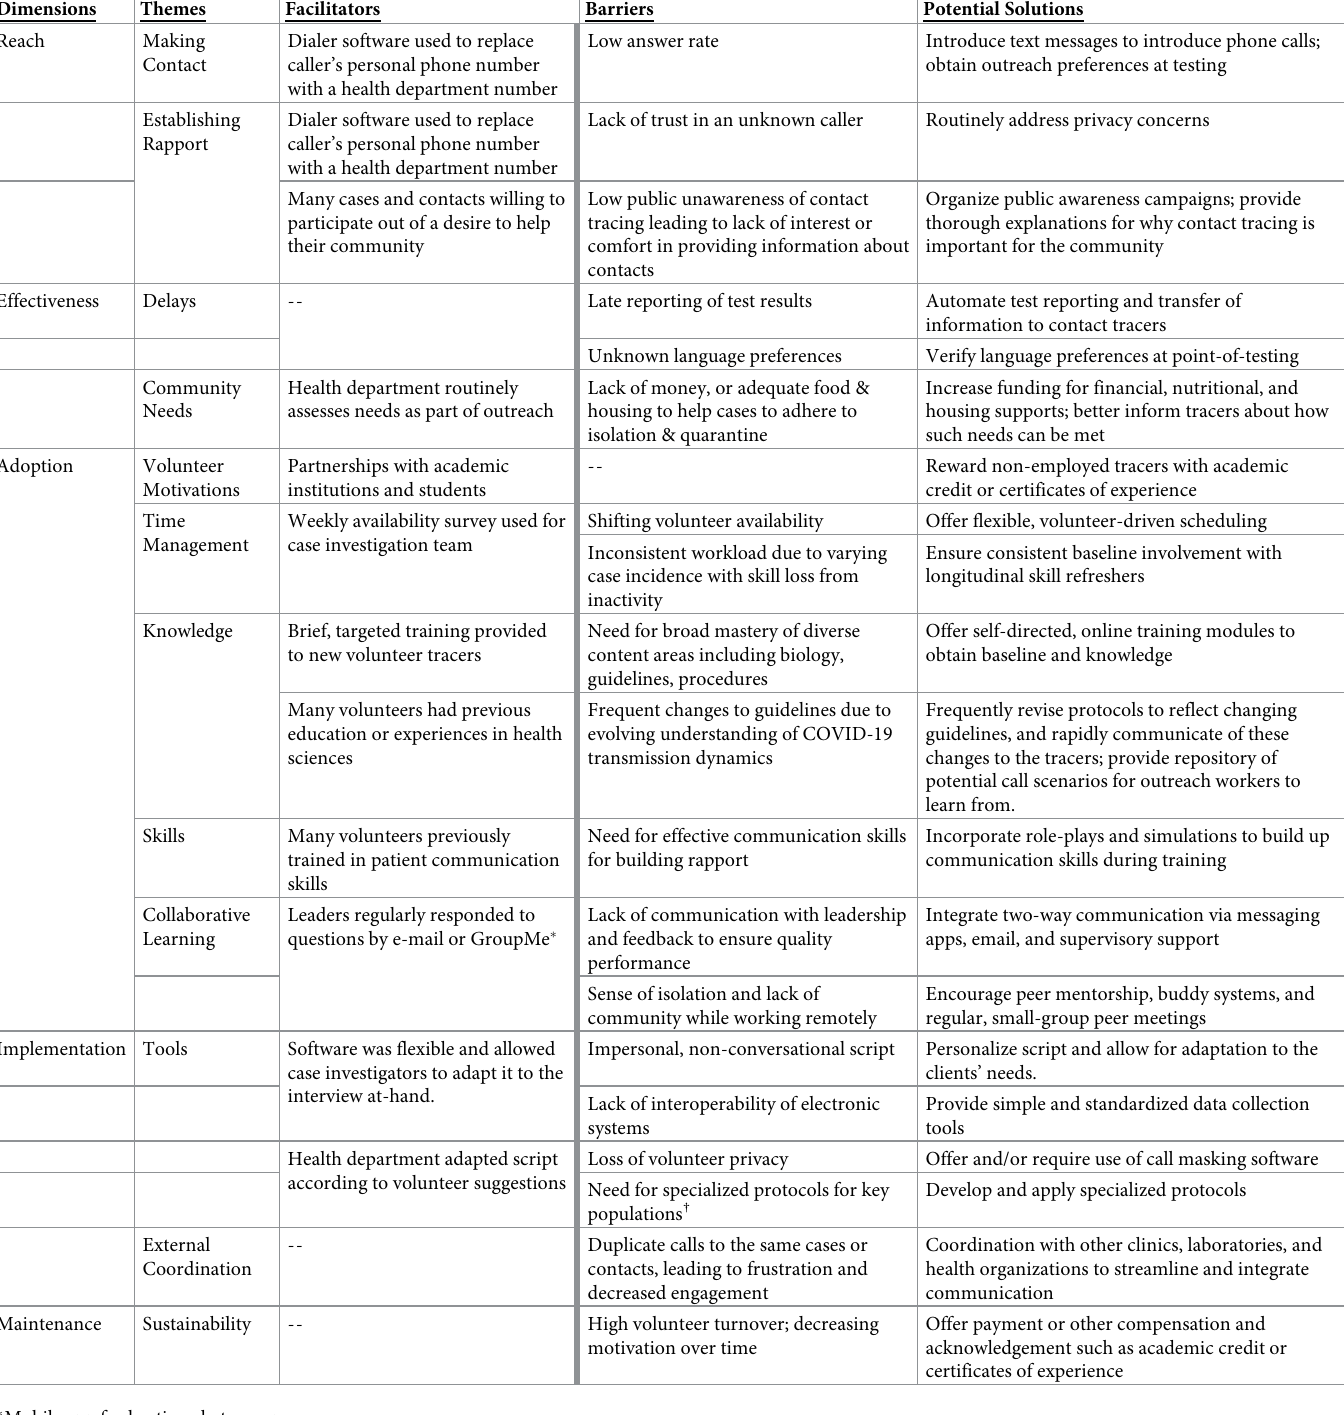
Table 2. Summary of findings organized by themes within the RE-AIM